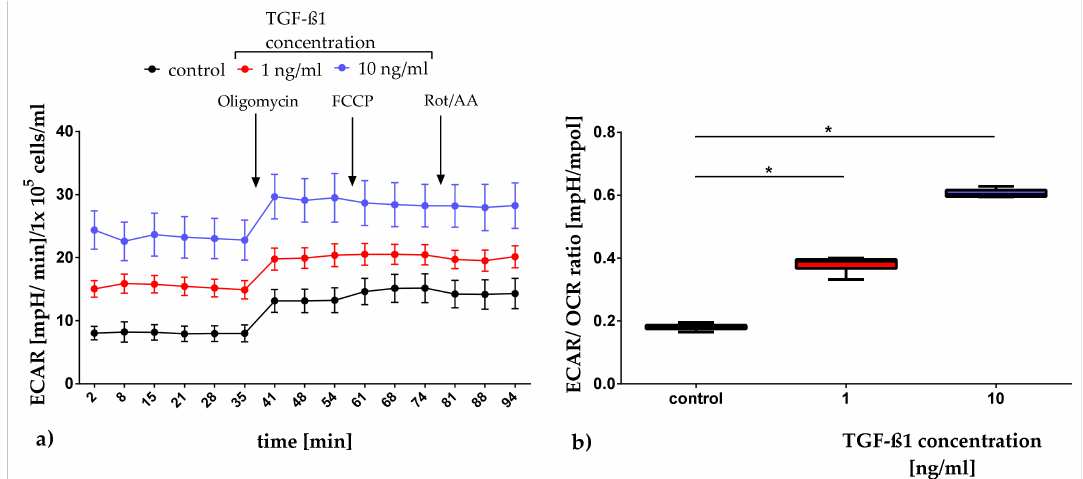
Figure 3. Quantification of the extracellular acidification rate (ECAR) after TGF-ß1 exposure on day 3. ECAR data are presented as a mean, with the standard error of the mean normalized to 1 × 10 5 cells / ml ( a ). The basal metabolism of the cultures was assessed by calculating ECAR / OCR ratios. Data were presented as box plots, with medians, interquartile ranges and minimum / maximum values ( b ). Since the dataset showed no Gaussian distribution (Shapiro-Wilk test), the statistical analysis was performed using the One-Way ANOVA test followed by Dunnett’s multiple comparison post hoc test ( n = 4). * p ≤ 0.05. Comparison to the control. FCCP: carbonyl-cynaide-4 (trifluoromethoxy) phenylhydrazone; Rot / AA: rotenone / antimycin